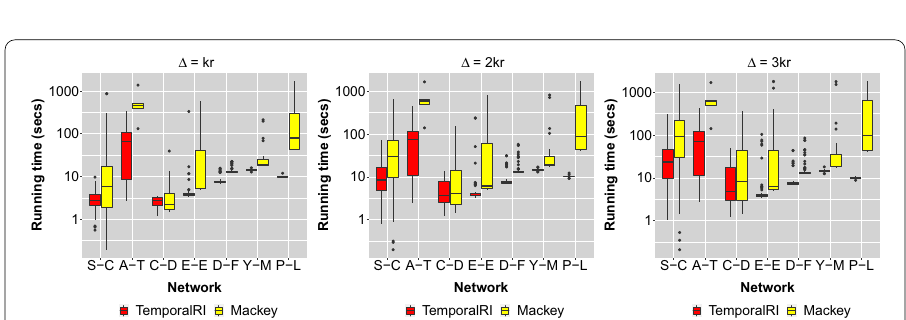
Fig. 6 Comparison between TemporalRI and Mackey’s algorithm on the set of queries with k = 6 contacts on varying (cid:31) . Boxplots of running times are built on the set of experiments in which both algorithms ended before the timeout. Network names are abbreviated